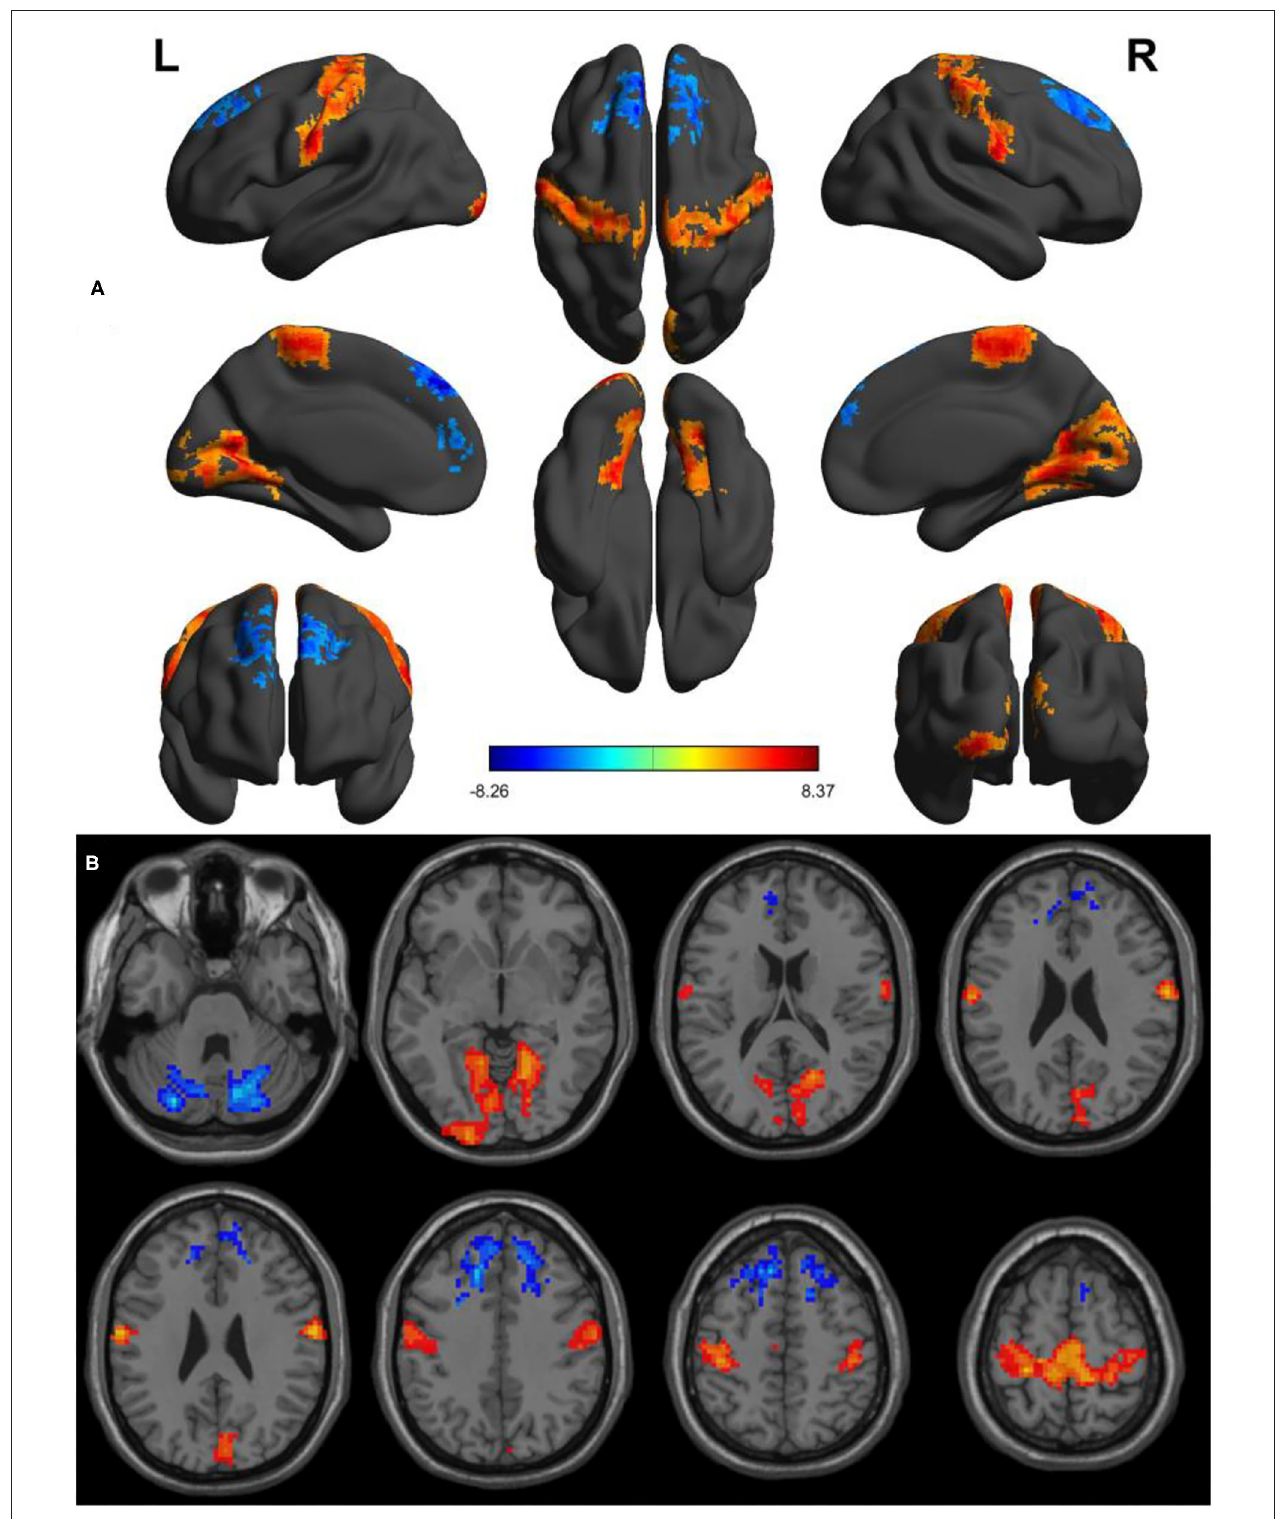
FIGURE 2 | Altered PerAF between SD status and normal sleep status. (A) A comprehensive view; (B) Axial view. Red color, increased PerAF areas; Blue color, decreased PerAF areas. R, right; L, left; PerAF, percent amplitude of fluctuation; SD, sleep deprivation.